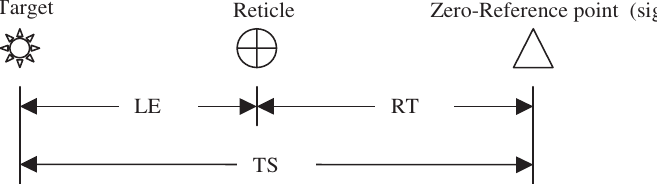
Fig. 3. Transfer function ‘X’